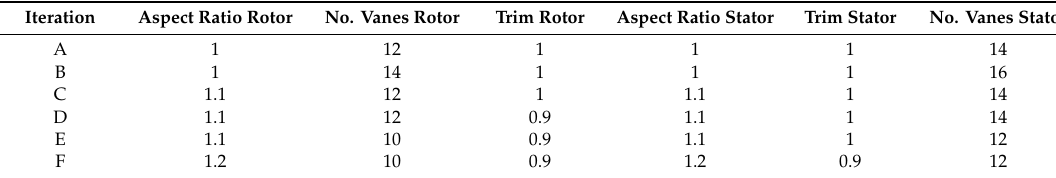
Table 11. Iteration procedure for the through-flow